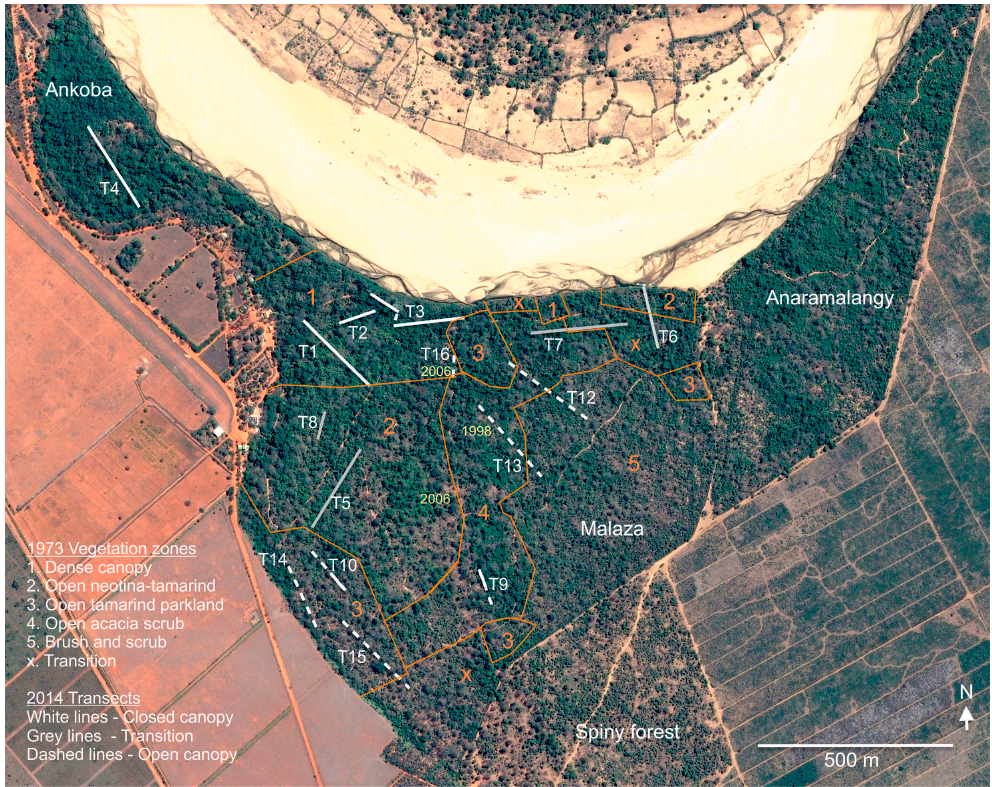
Figure 6. View of Ankoba and Malaza with the river at low water. The red lines show the positions of the vegetation zones as defined in 1973. The 2014 transects are numbered and dates mark the locations of the 1998 and 2006 burns. The ‘dogleg’ transect, T3, crosses the riverside trail where it touches the riverbank.